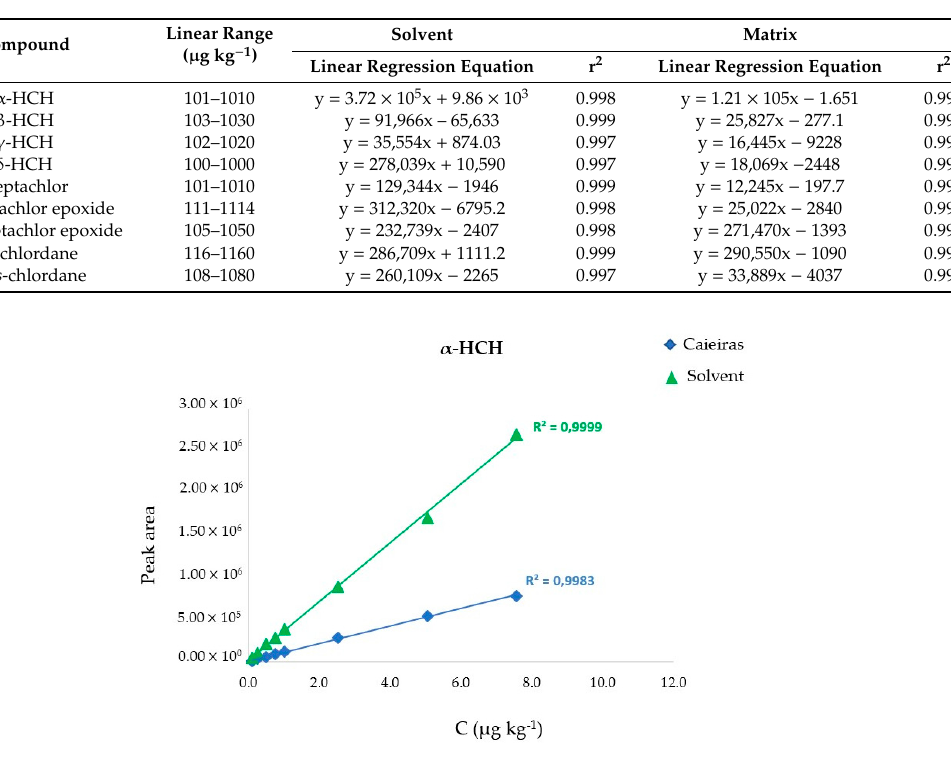
Table 3. Linear range, linear regression equation, and determination coe ffi cient of solvent and matrix sample groups.